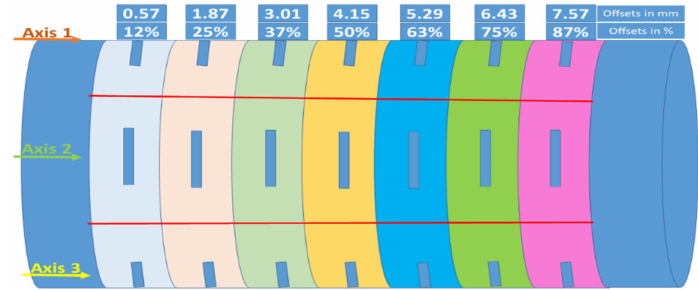
Figure 4. Division of the cylinder in sections corresponding to crack locations. The labels represent the crack offset in percentage and absolute (mm) values in the horizontal direction from the excitation location. In the vertical direction, the pipe is divided at the boundaries shown by two red horizontal lines in Figure 4, which create three axes: axis 1, axis 2, and axis 3, which may hold a crack. As a result, certain sections can be drawn on the pipe body, which may act as a set of probable damage locations for the estimation algorithm. The corresponding pipe sections are illustrated in Figure 5. The developed numerical model will enable the operator to output one of these sections as a probable damage location based on the best match with the dataset. To easily identify each crack, a nomenclature is defined (Table 2) that will allocate a unique label to each crack depending upon its location with respect to the axis number, offset percentage, and number of cracks (either single crack or multiple).